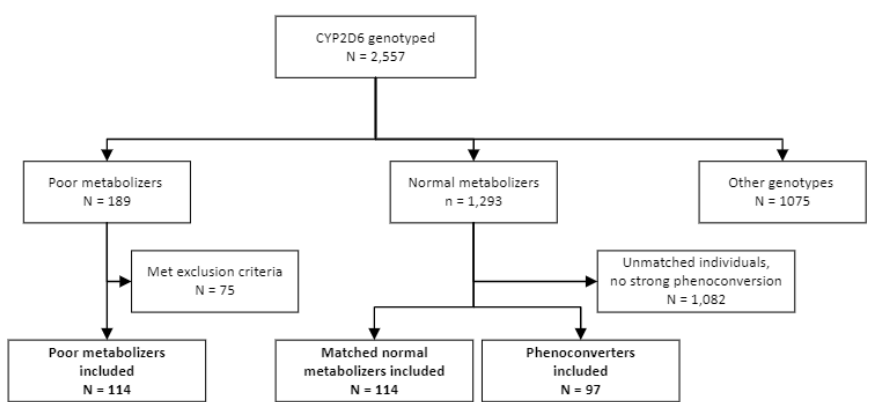
Figure 1. Flowchart of study participants.